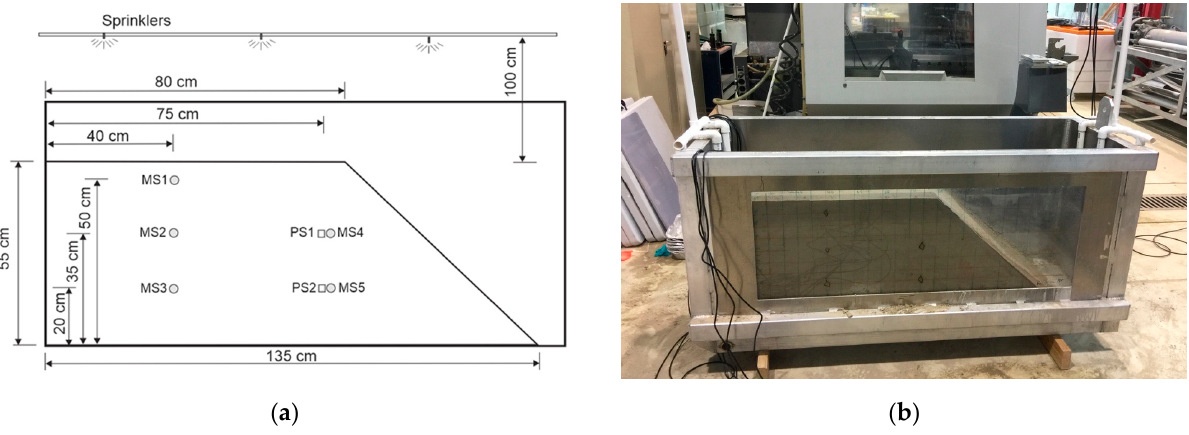
Figure 2. Flume apparatus: ( a ) location of the pore water pressure sensors (PS1 and PS2) and water content sensors (MS1-MS5); ( b ) an image of the slope prior to testing.